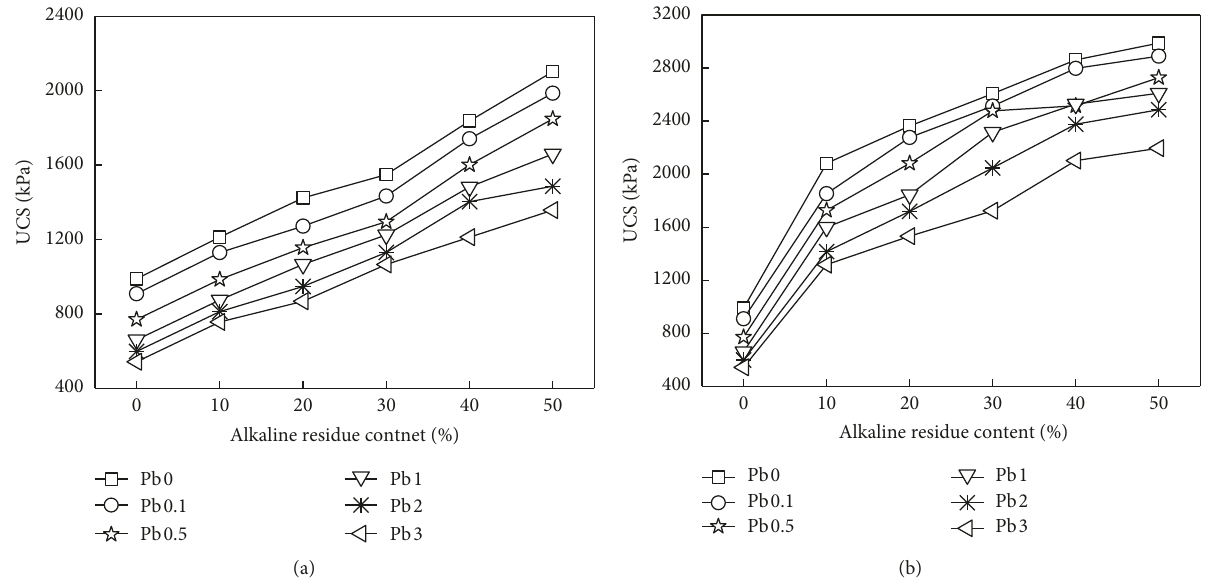
Figure 3: Evolutions of the UCS with the alkaline residue content of the specimen. Curing times of (a) 0d and (b) 28d.